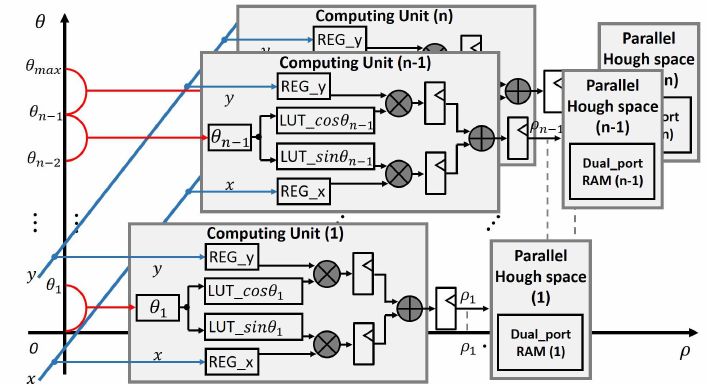
Figure 2. Hardware implementation for ρ and θ computation with n -fold parallelism.